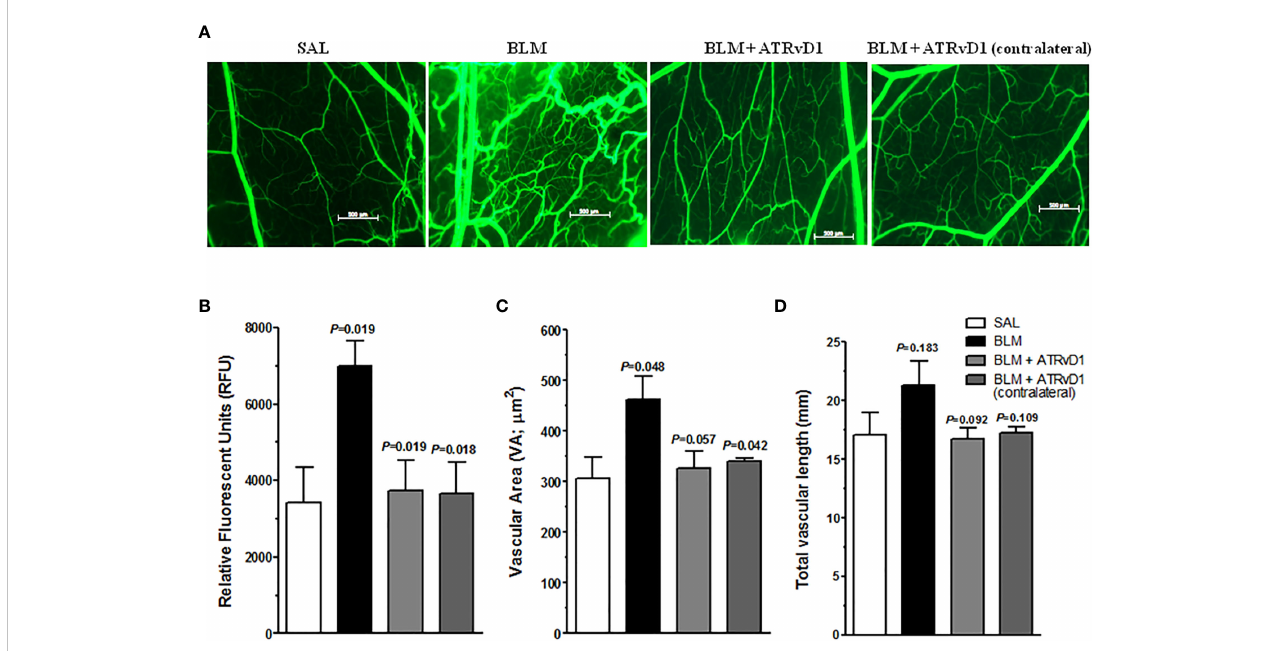
FIGURE 5 ATRvD1 treatment inhibits BLM-induced angiogenesis in HCP. (A) Representative fl uorescent light images of HCP preparation after SAL, BLM (1 U/100 µL/ hamster – injected into the cheek pouch), BLM + ATRvD1 (25 µg/kg - 100 µL i.v.) treatments, and contralateral images of HCP in BLM-treated hamsters. The image area is 5 mm 2 . (B – D) Microvascular alterations were quanti fi ed by measuring the fl uorescence measurement (RFU), vascular area (VA), and total vascular length (TVL). Results represent mean ± SD from independent experiments. The p-value on the top of the BLM bar represents the comparison to the SAL group, while the others values were compared to the BLM